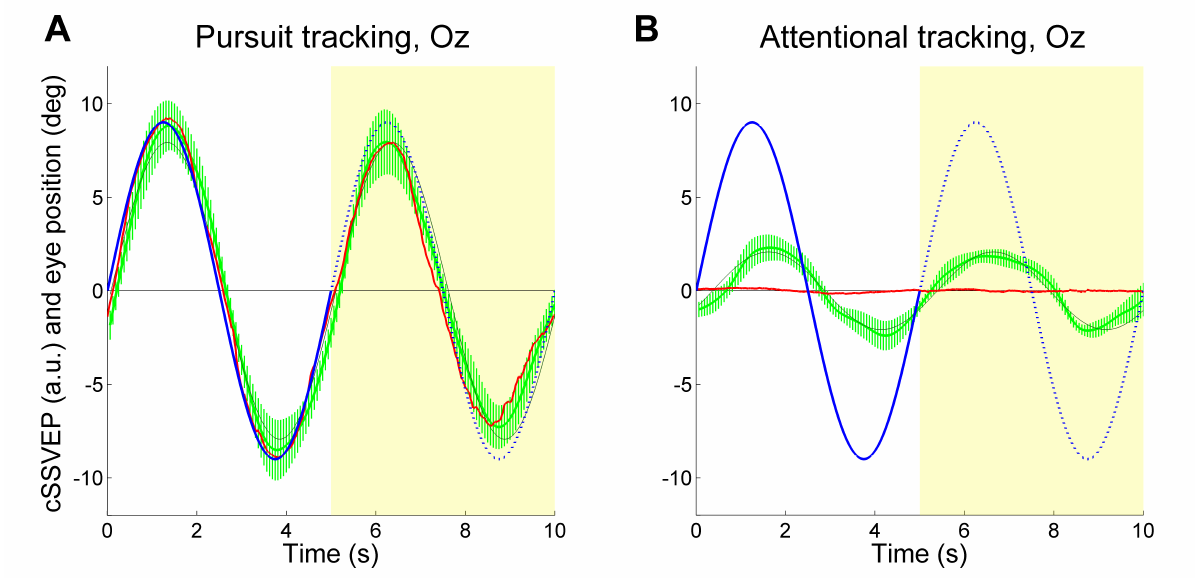
Figure 5: Average cSSVEP modulation (green traces) during Vertical tracking (Pursuit tracking and Attentional tracking), using the signal from the electrode at Oz. Conventions as in Figure